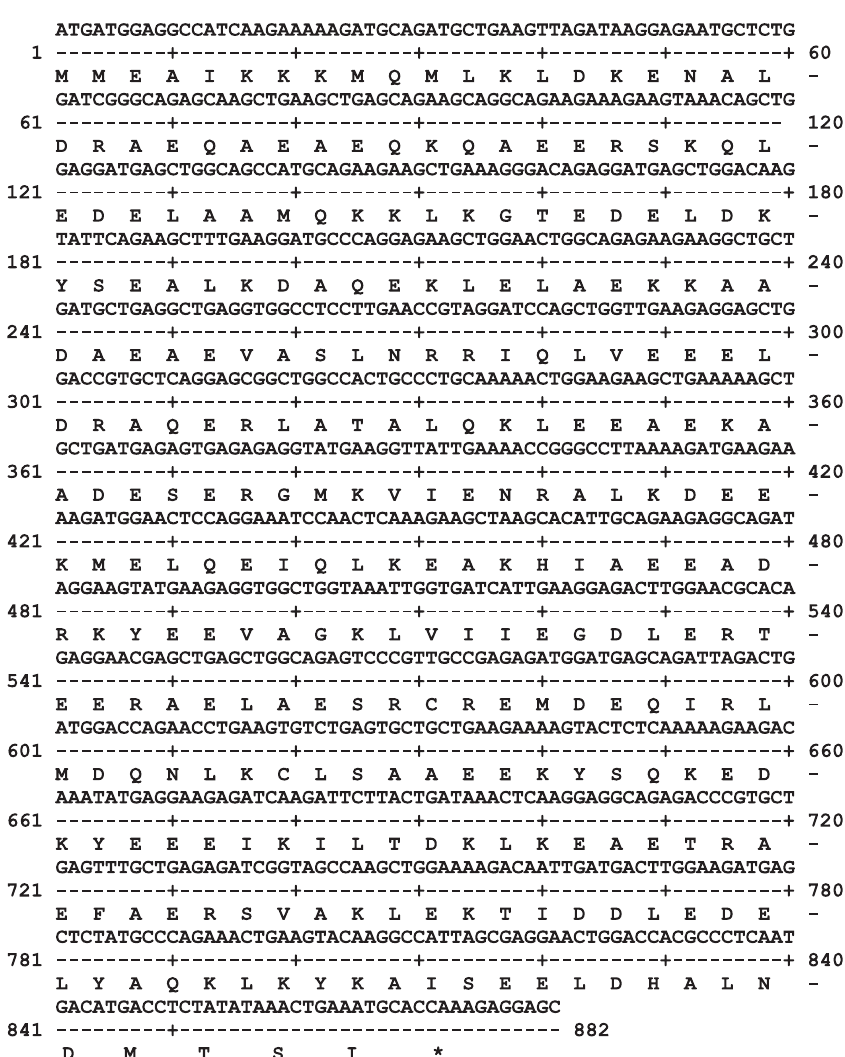
Figure 3: Te nucleotide sequence of cDNA and deduced amino acid sequence of Cyn heart TPM3 α